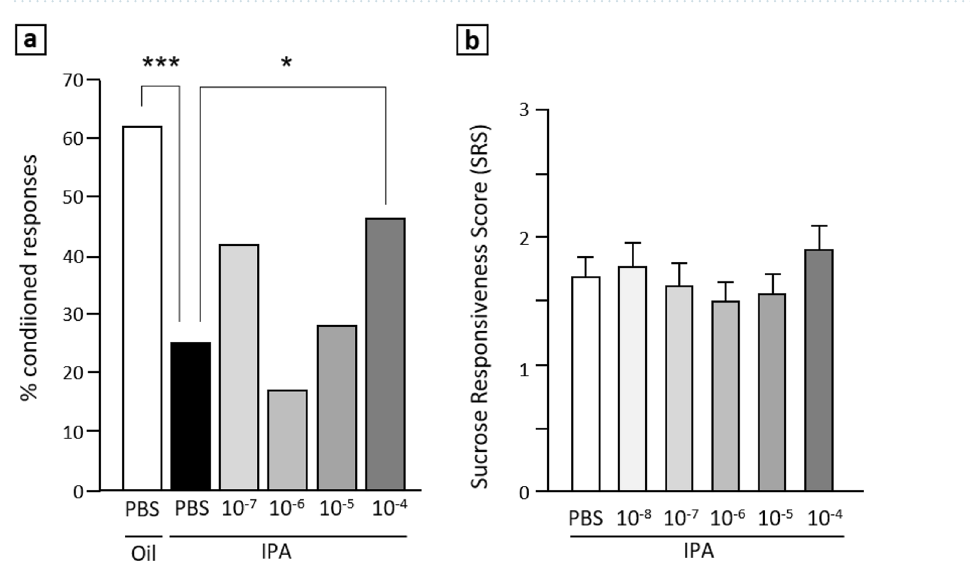
Figure 3. Effects of A8 on stressed bees. ( a ) Learning: proportions of individuals showing a conditioned response to the odorant paired with sucrose, at the end of the conditioning session (third trial). Bees were injected either with PBS or A8, then exposed to IPA or paraffin oil only (negative controls). While exposure to IPA significantly reduced learning performance in PBS-injected bees, this effect was restored by an injection of 10 –4 M A8. *: p < 0.025; *** p < 0.0005 (PBS: n = 100; A8: n = 47–99/group). ( b ) Sucrose responsiveness: mean sucrose responsiveness score values in bees injected with PBS or A8 before exposure to IPA. Even at the highest dose, A8 could not significantly increase SRS as compared to PBS controls (PBS: n = 78; A8: n = 44–47/group) (2